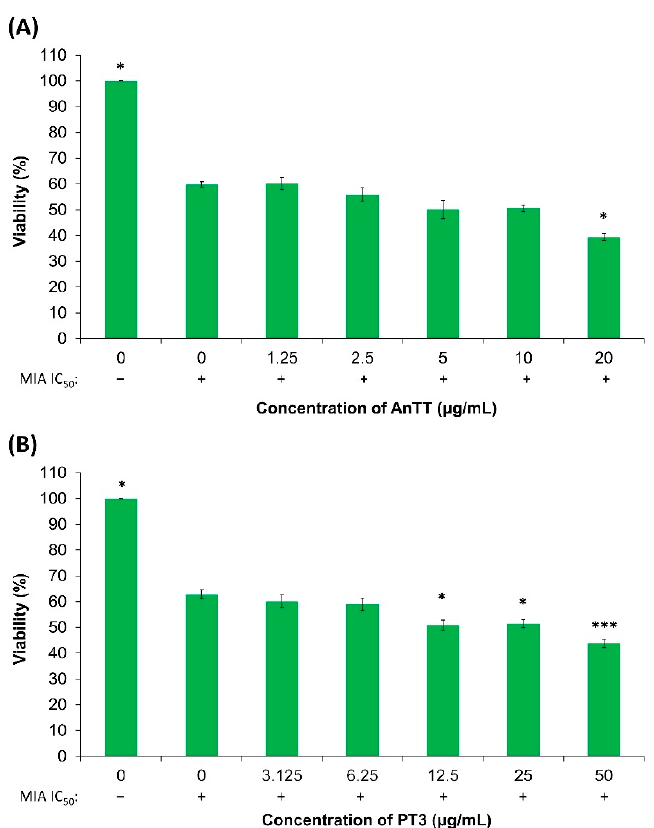
Figure 2. The viability of SW1353 chondrocytes over a 24 h pre-treatment model with AnTT ( A ) or PT3 ( B ), followed by 24 h treatment of MIA at IC 50 of 31.5 µM. The results were obtained from 3 independent experiments with 4 technical replicates during measurement. The data were displayed in mean ± SEM. * and *** indicate a significant difference of p < 0.05 and p < 0.001 compared to the MIA control group.